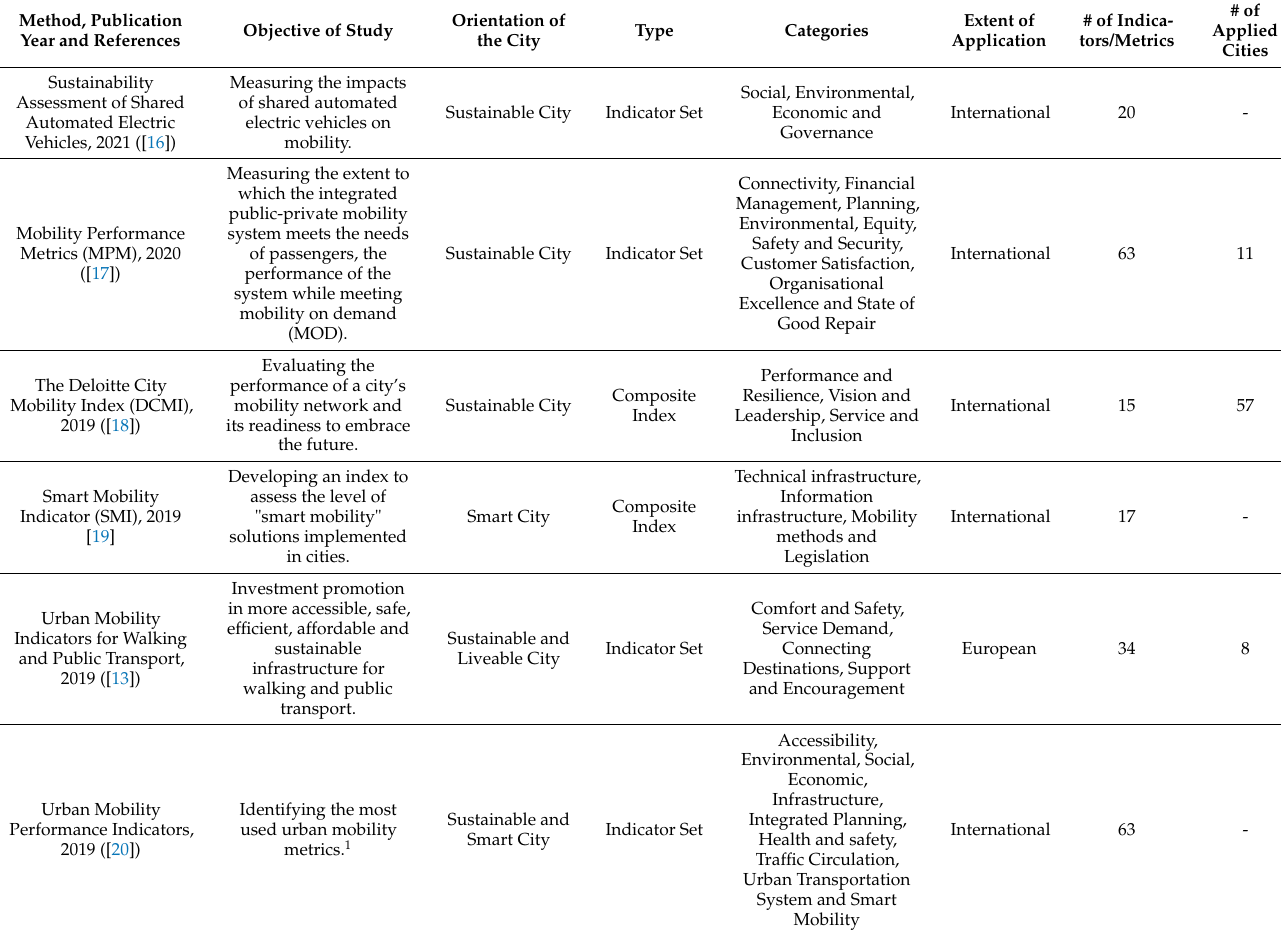
Table 1. A list of some previous studies considered in the literature review for the selection of indicators within the period from 2010 to 2021, arranged in descending order for the year of publication, followed by ascending order for the number of